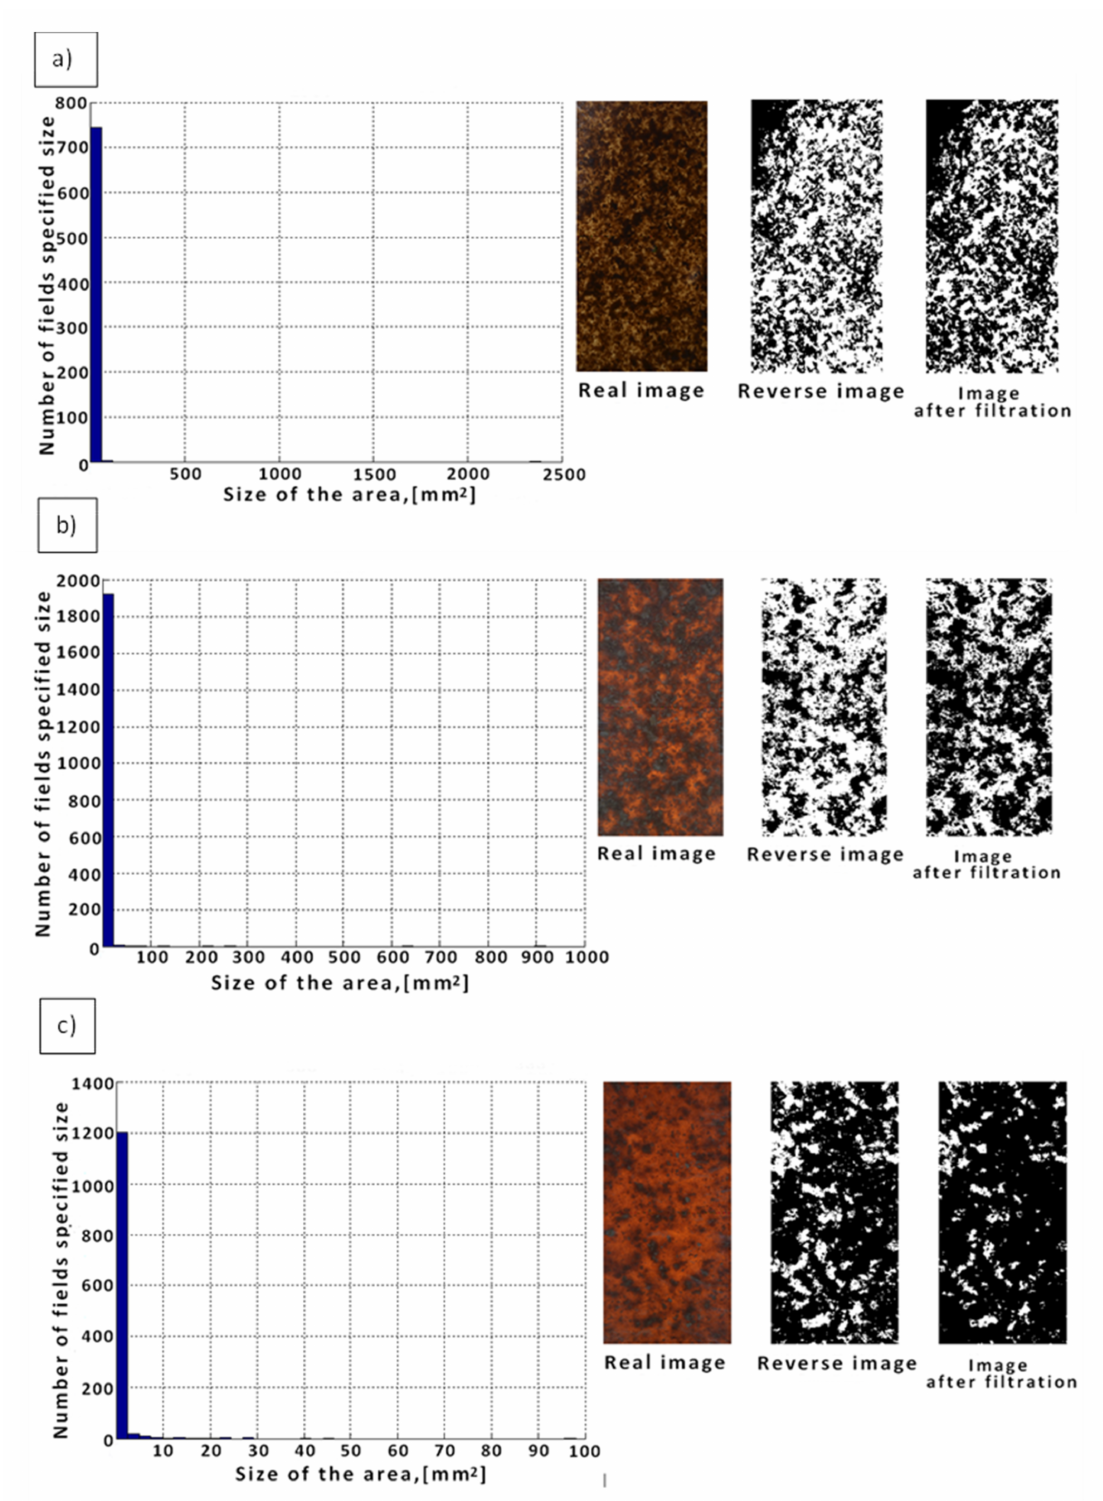
Figure 8. Histogram of the determined numbers and areas of agglomerates for WPCs with the addition of wood flour (PP/Lignocel C120) at constant: W S = 1.7 mm, i = 35 w t %, and variable rotational speed: ( a ) n = 12 rpm, ( b ) n = 26 rpm, and ( c ) n = 40